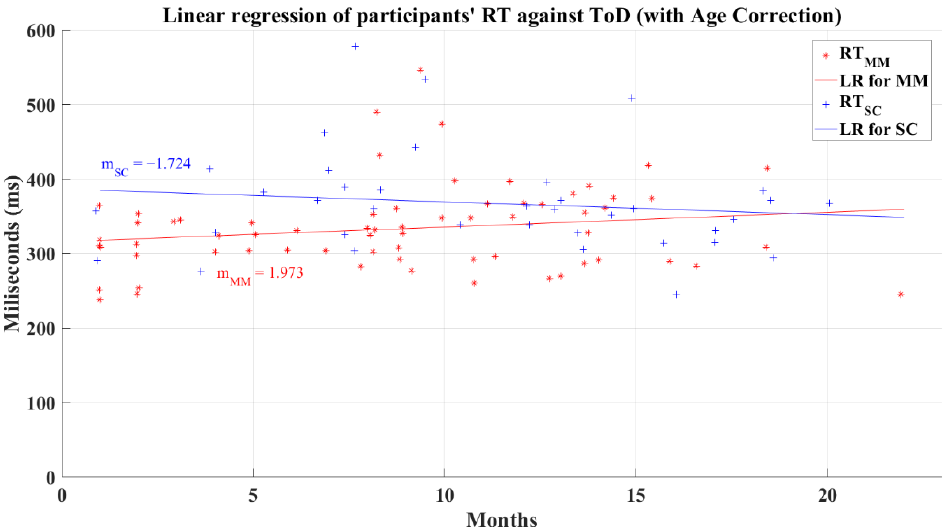
Figure 18. Linear regression for participants’ simple reaction time and elapsed time of diagnosis with corrected age-effect. Red line—linear regression for Mild-Moderate post-COVID group (LR for MM); blue line—linear regression for Severe-Critical post-COVID group (LR for SC); RT MM , Mild-Moderate group’s reaction time; RT SC , Severe-Critical group’s reaction time; m MM , Mild-Moderate group’s slope; m SC , Severe-Critical group’s